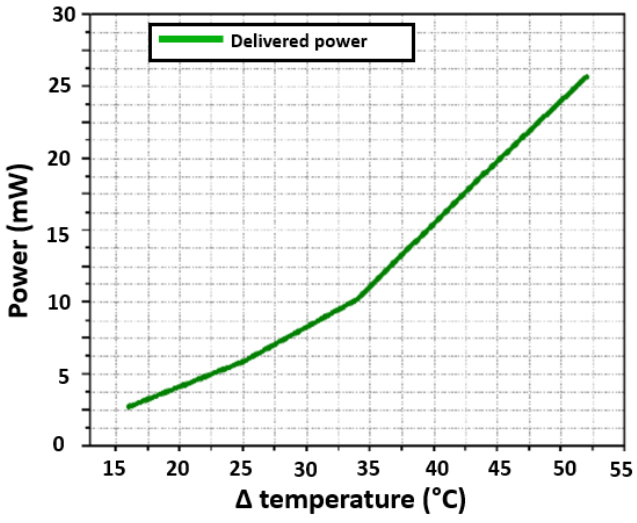
Figure 20. Delivered power by the thermoelectric